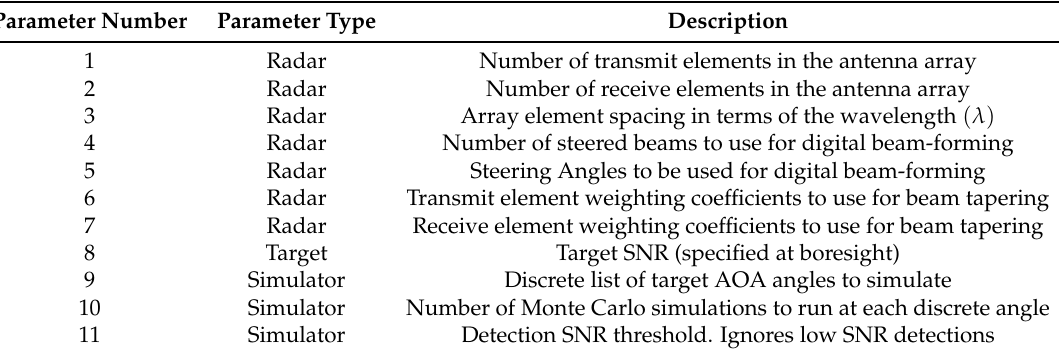
Table 1. Simulator input